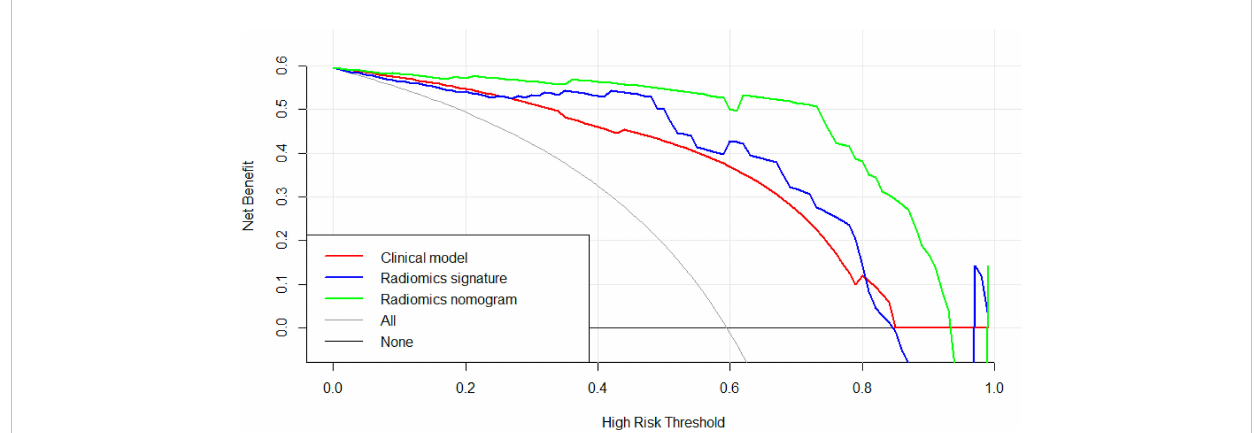
FIGURE 9 The decision curve analysis of CT fi ndings model, radiomics model and radiomics nomogram in test cohort. The green line represents radiomics nomogram. The blue line represents radiomics model. The red line represents CT fi ndings model. The grey line represents the assumption that all patients had pancreatic ductal adenocarcinoma (PDAC) (All). The black line represents the assumption that all patients had focal autoimmune pancreatitis (fAIP) (none). Threshold probabilities in clinical decisions take arbitrary values and patients will bene fi t more from the radiomics nomogram than either the treat-no-patient or treat-all-patient